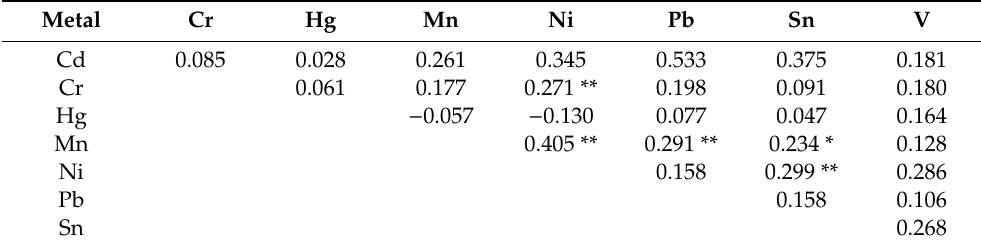
Table 2. Correlations between metal concentrations in hair of 94 schoolchildren living in Tarragona County